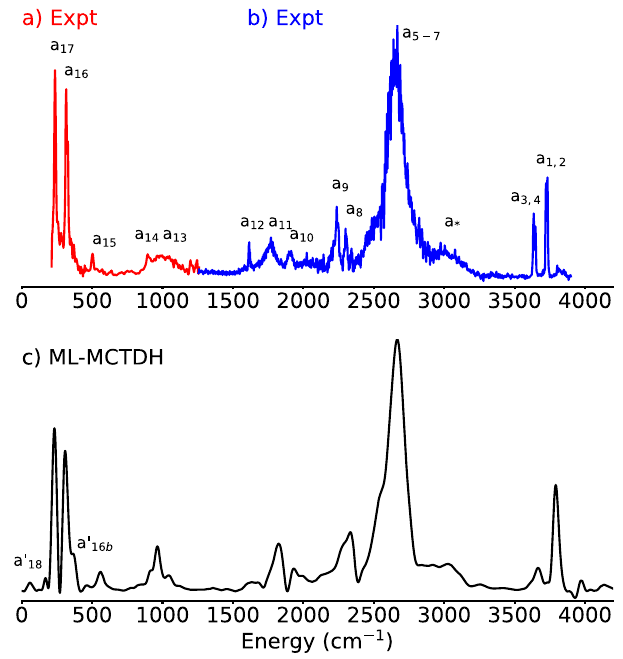
Fig.1|AbsorptionspectrumoftheEigenCationH 9 O + 4 .a Experimentalspectrum from ref. 13. b Experimental spectrum from ref. 9. c Calculated spectrum (red- shifted 70cm − 1 to match experimental line positions). Both experimental spectra detectedviaphotodissociationofD 2 taggedclusters.Theassignmentsofthepeaks follow the nomenclature of refs. 9, 13 and are discussed in Supplementary Table 1. Source data are provided under